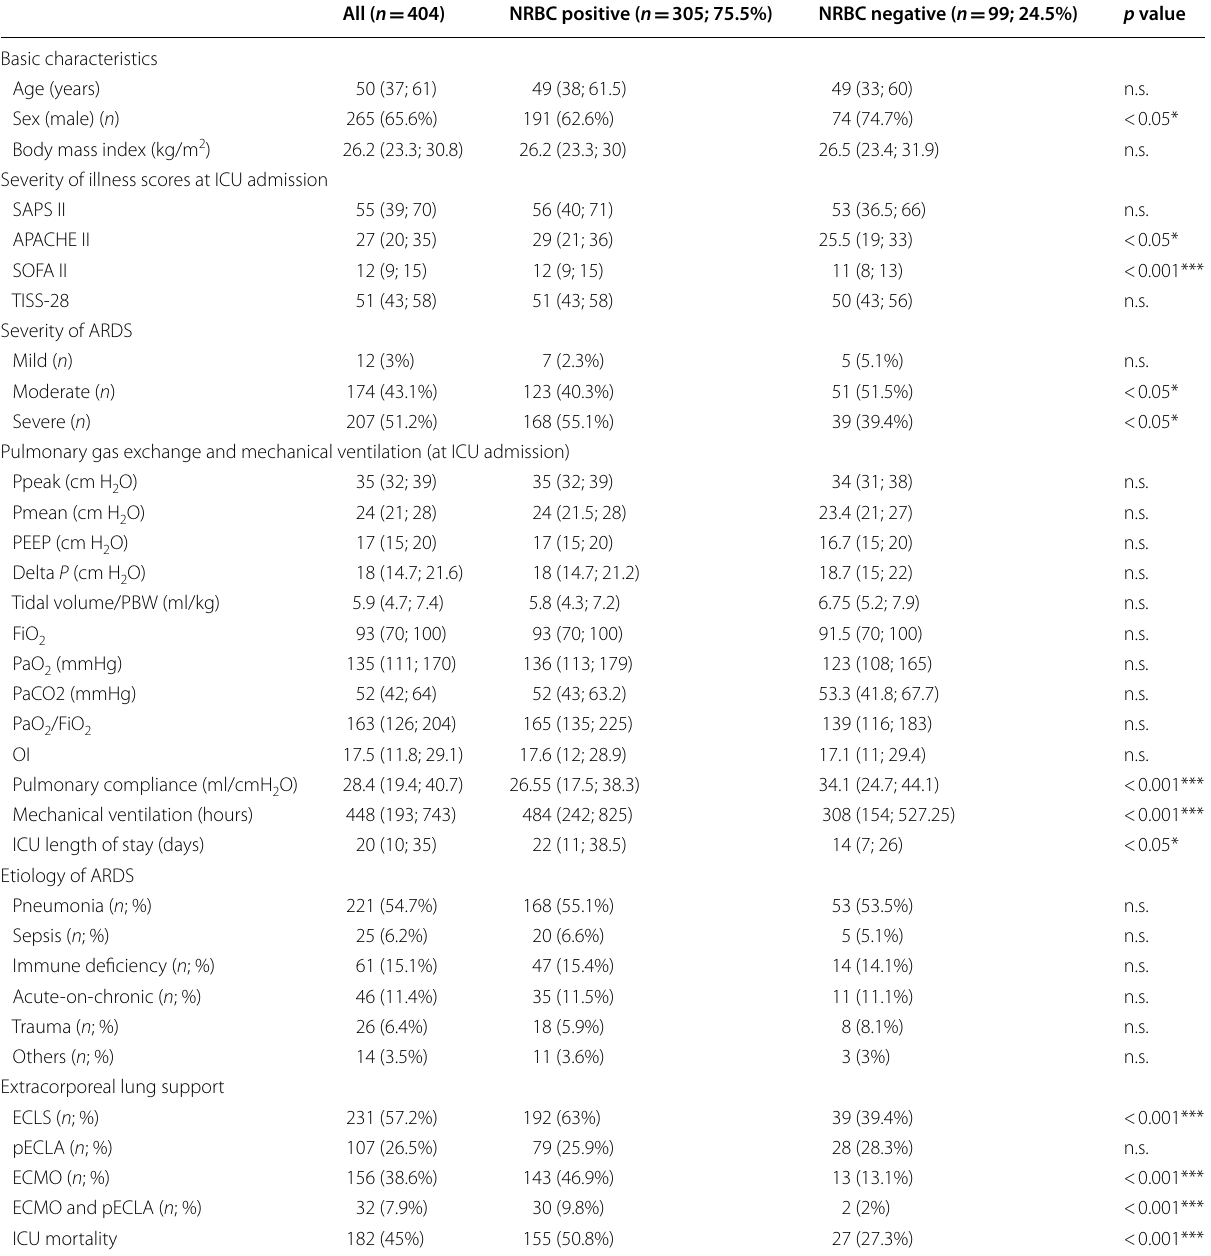
Table 1 Patient characteristics and comparison between NRBC-positive and NRBC-negative ARDS